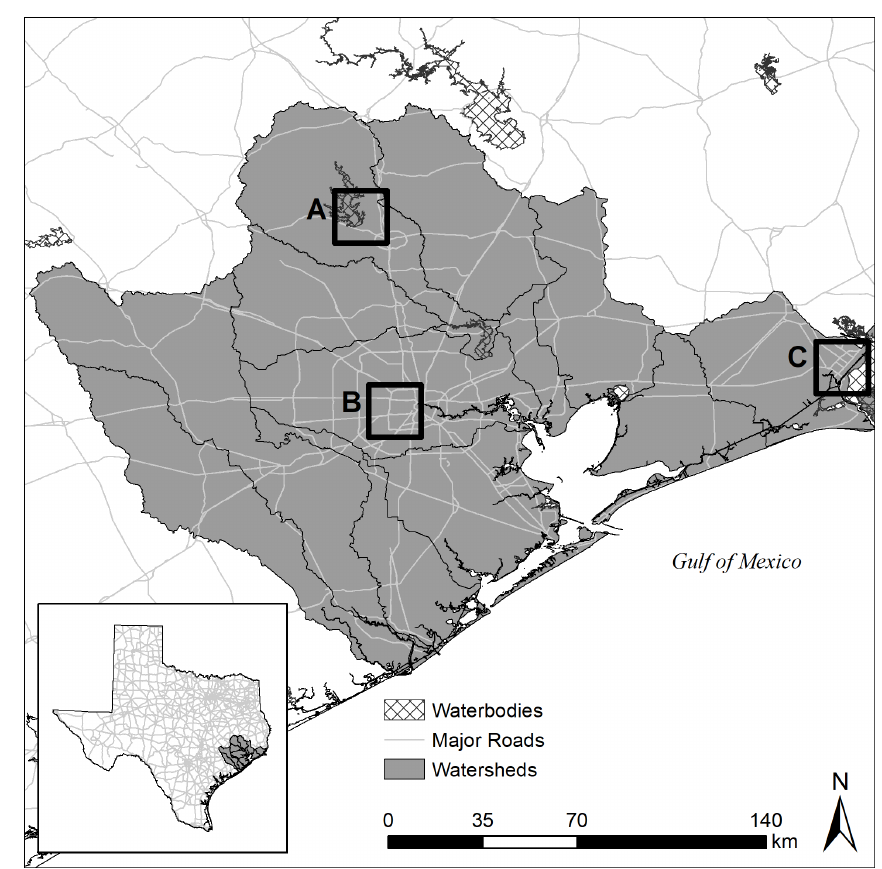
Figure 1. Map of the study area. Data originated from the US Census Bureau and the US Geological